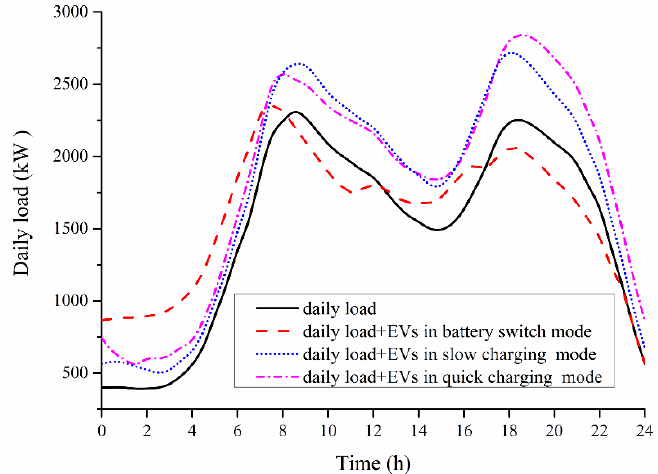
Figure 11. The daily load curve before and after EVs are